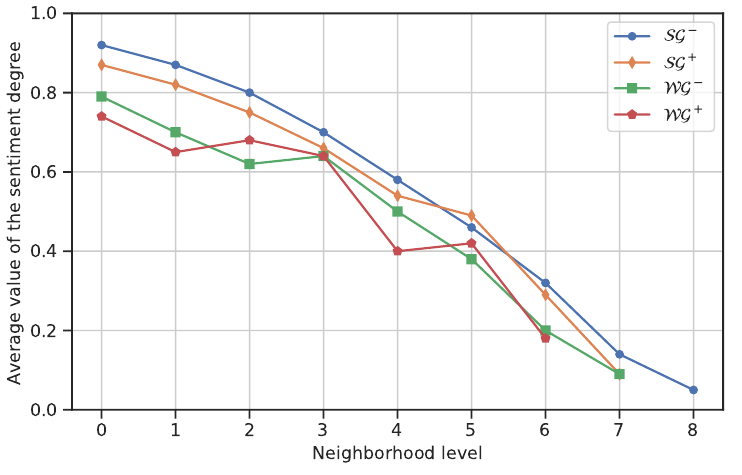
Figure 3. Variation of the mean value of the sentiment degree on t j of users against the neighborhood level they belong